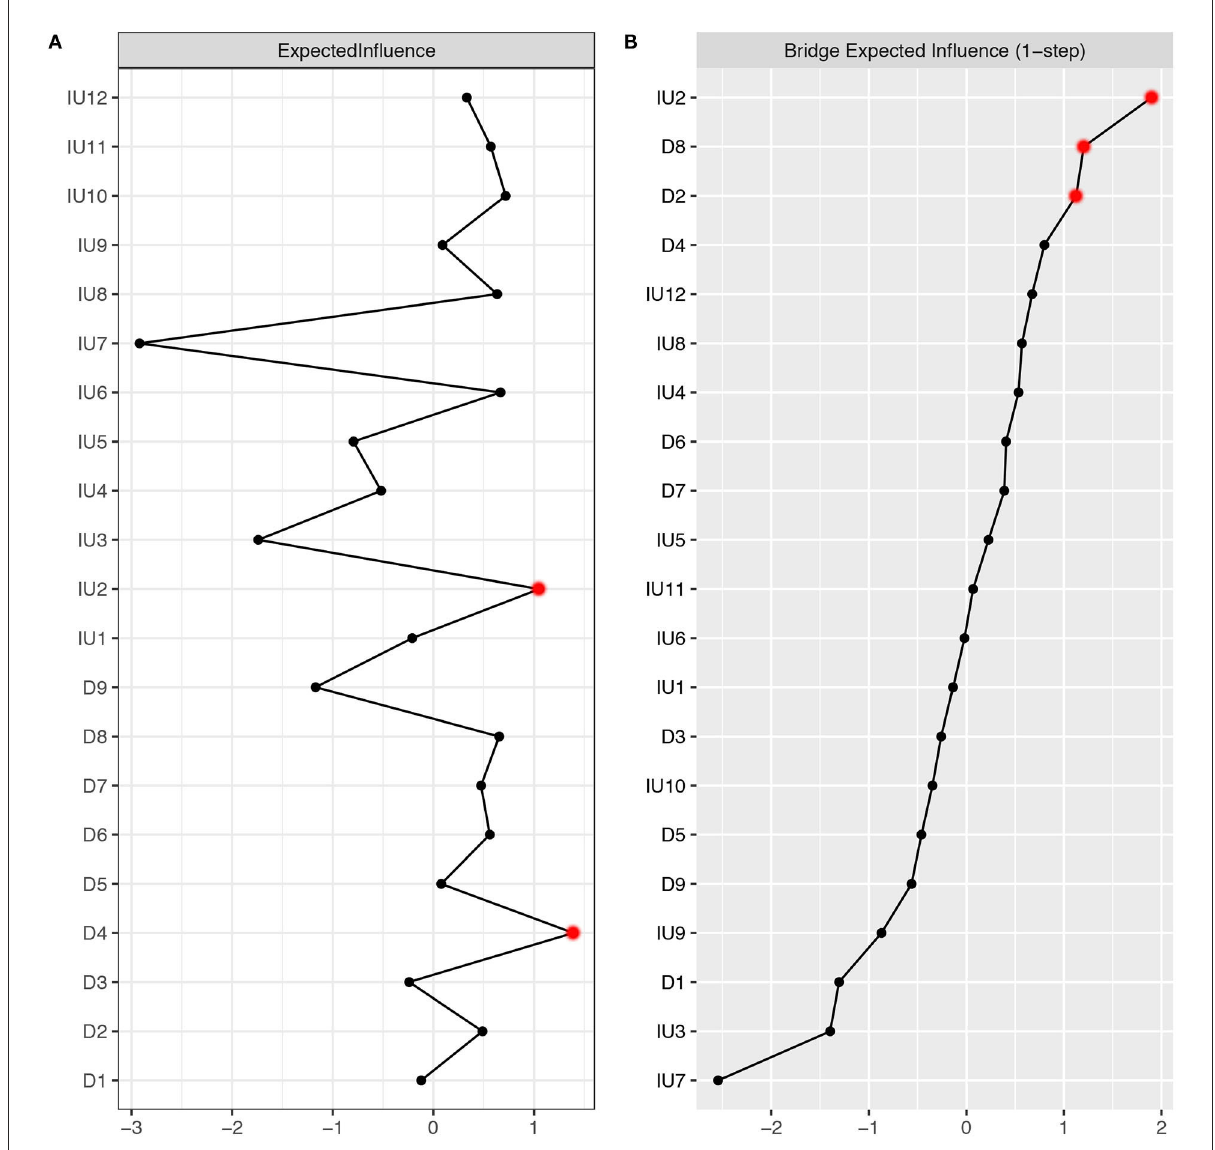
FIGURE2 (A) Centrality plot depicted the expected influence (z-score) of each variable chosen in the final network. (B) Centrality plot depicted the bridge expected influence (z-score) of each variable chosen in the final network. The text of IU and depression can be seen in Table